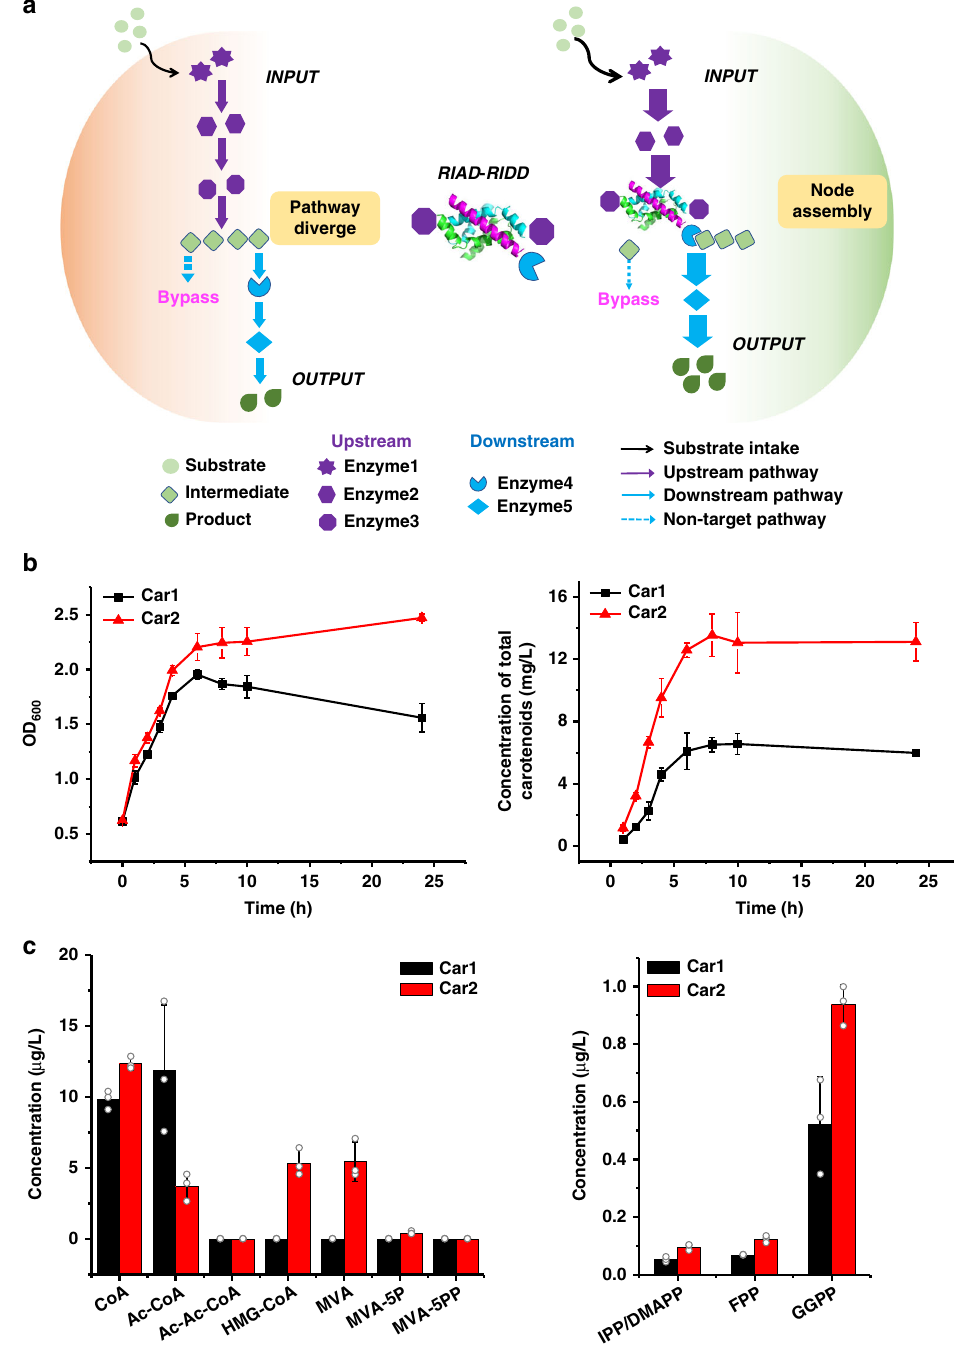
Fig. 3 Idi-CrtE assembly increases the metabolic fl ux of carotenoid biosynthesis in shake- fl ask fermentation. a A scheme showing that the Idi-CrtE assembly installs a metabolic node that guide the fl ux towards carotenoid synthesis. Green fi lled circle: substrate; green fi lled rhombus: intermediate; green drop: product. Seven horns star, hexagon, octagon: enzymes of the upstream. Notched circle, blue fi lled rhombus: enzymes of the downstream. Black arrow: substrate intake; purple arrow: upstream pathway; blue arrow: downstream pathway; blue dotted arrow: non-target pathway. b Enzyme assembly increases carotenoid production and the cell mass. Black line: Car1; red line: Car2. c Global changes of the metabolic intermediates. Black column: Car1; red column: Car2. Error bars indicate the standard deviations of three biological replicates. Source data are provided as a Source Data fi